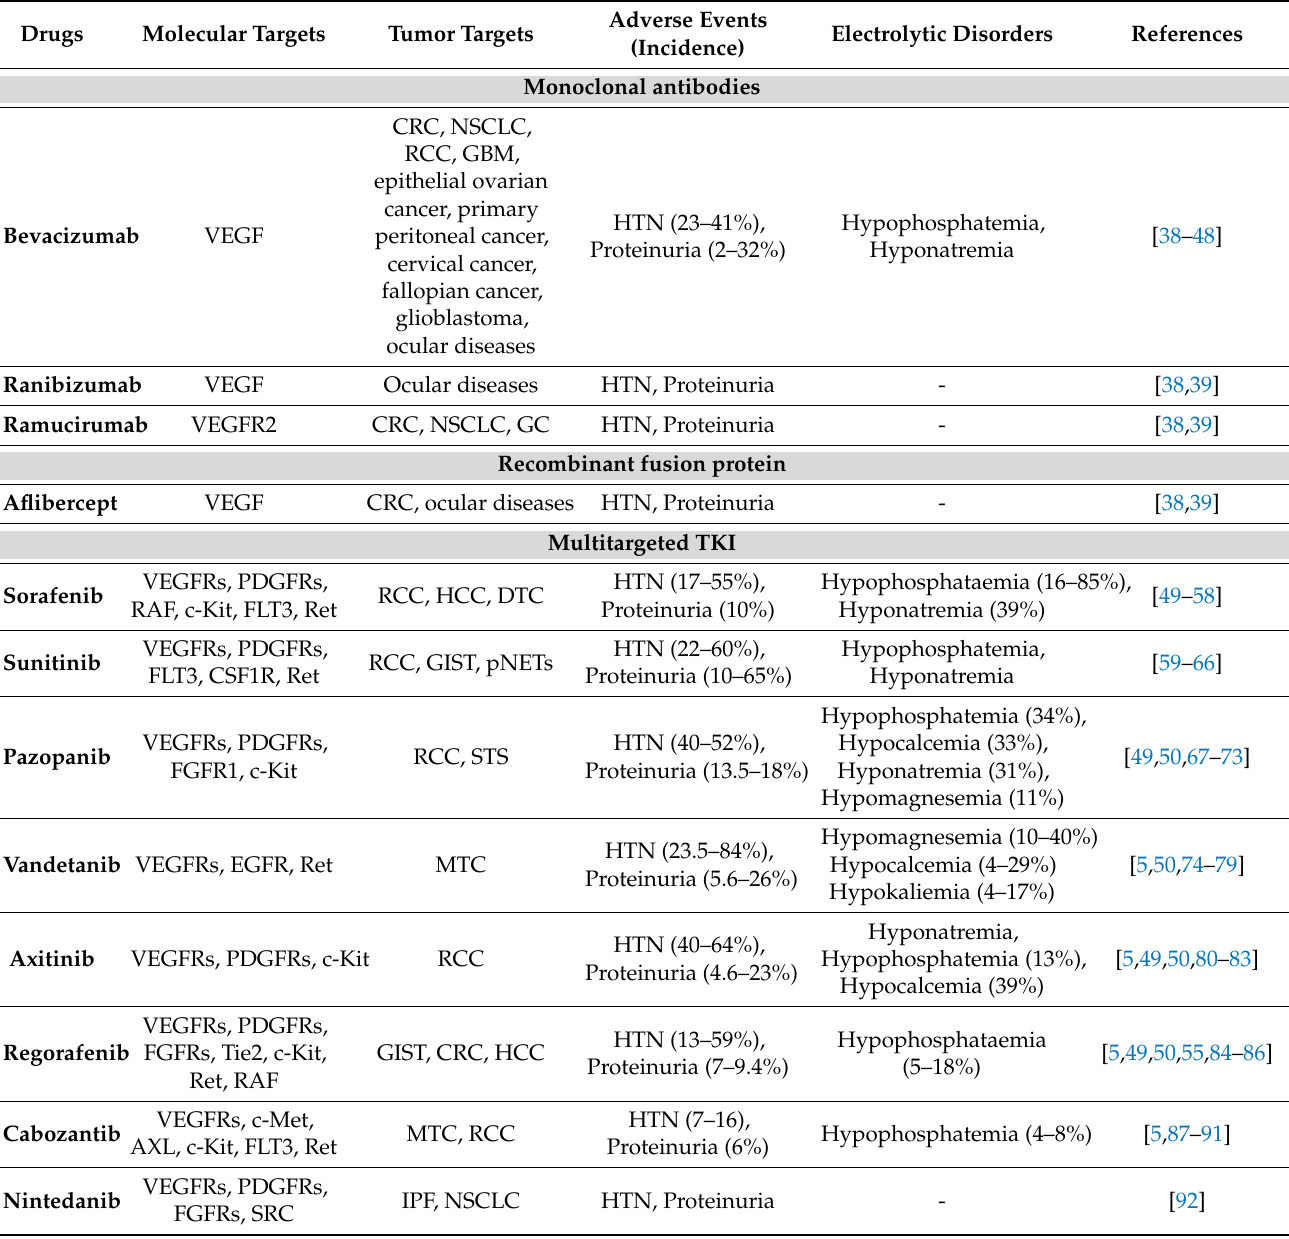
Table 1. Incidence of renal manifestations and electrolytic disorders under anti-angiogenic targeted therapies. Drugs Molecular Targets Tumor